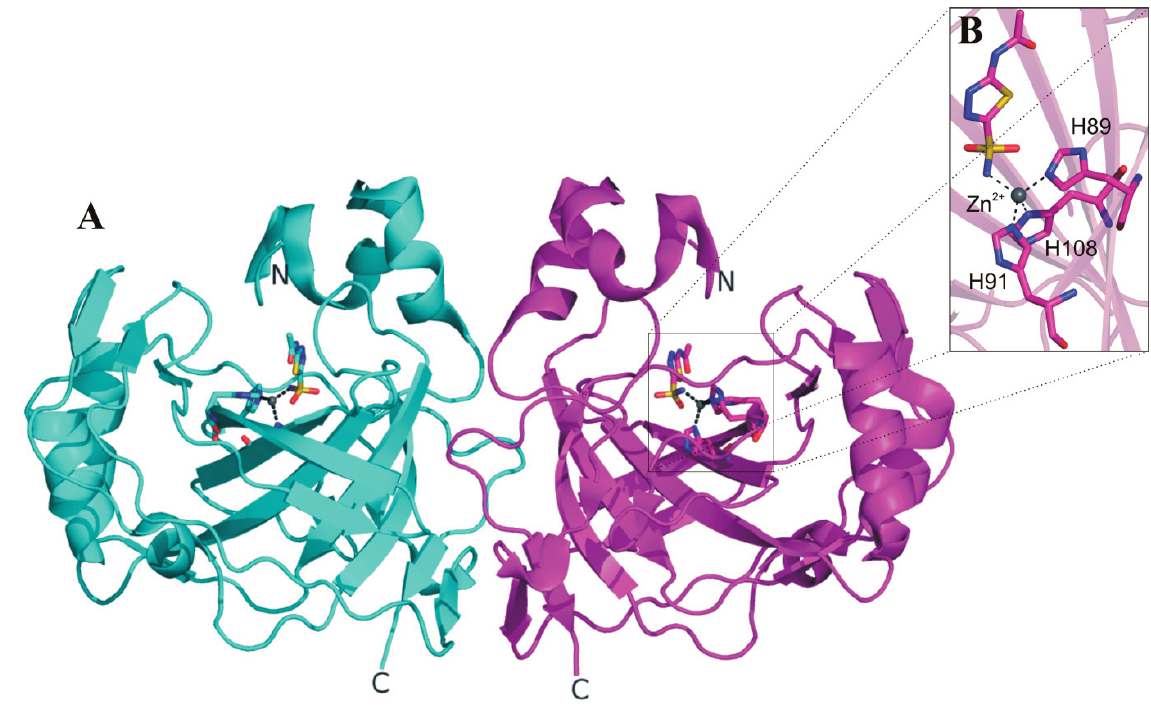
Figure 3. ( A ) SspCA dimer structure (PDB code 4G7A) with one monomer shown in cyan and the other one in magenta; ( B ) enlarged view of SspCA active site showing the zinc ion